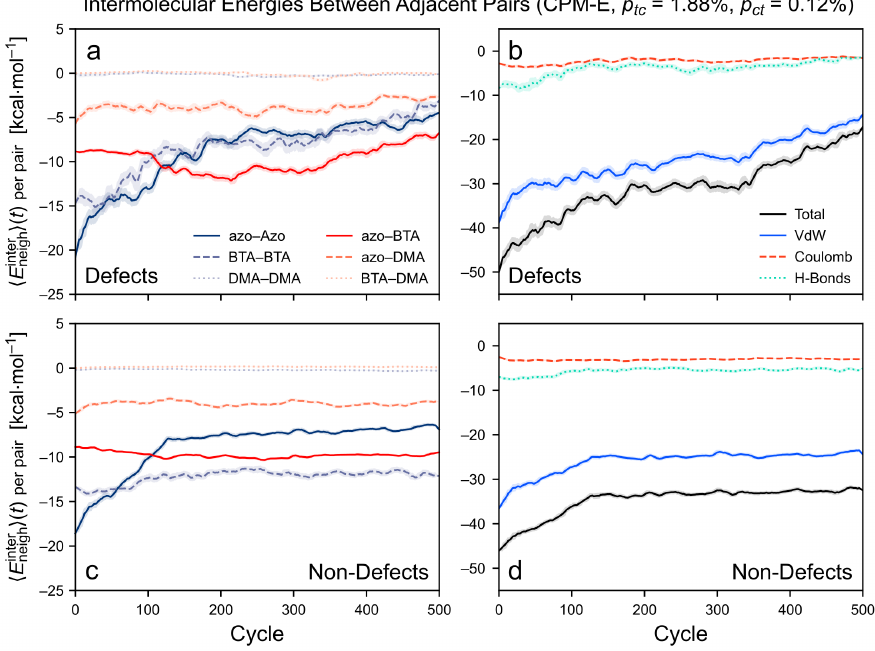
Figure 12. Time evolution of the intermolecular energies between the adjacent monomer pairs in the TrisAzo stack for the CPM-E simulation with p tc = 1.88%, p ct = 0.12%. The energy contributions are averaged for ( a , b ) all neighboring monomer pairs with defects, and ( c , d ) without defects. Left- hand side: energy decomposition by interactions between the different physical parts of the TrisAzo molecules. Right-hand side: energy decomposition by types of non-covalent interactions. Each curve is smoothed via a running average (window size of 20 cycles, corresponding to 0.96ns). Shaded error bands indicate the standard deviation of the raw curve in each